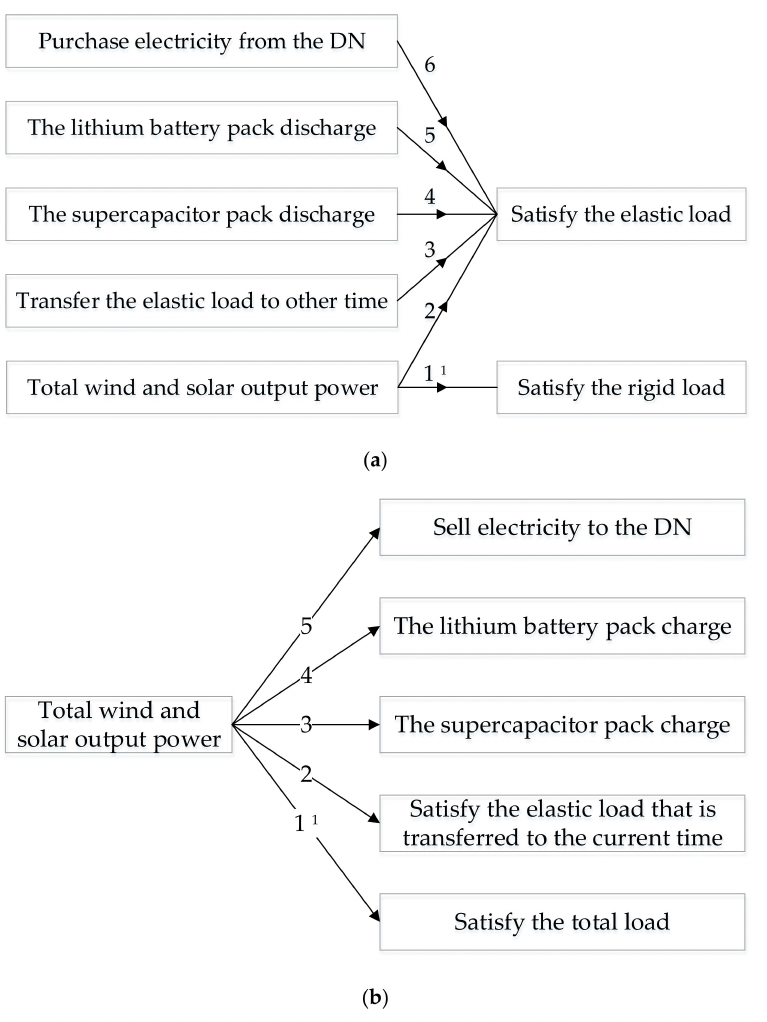
Figure 2. The supply order of the power and the satisfied order of the load. ( a ) When the total wind and solar output power is less than the total load at time t ; ( b ) When the total wind and solar output power is greater than the total load at time t . 1 The number represents the order, the smaller the number, the more priority the